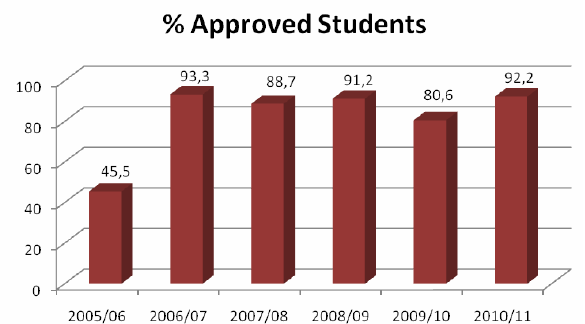
Figure 3. Percentage of approved students along the last 5 academic years.